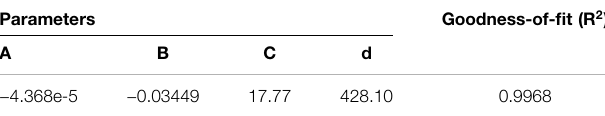
TABLE2| Datafordisplacementtrendparametersassociatedwiththepolynomial fi